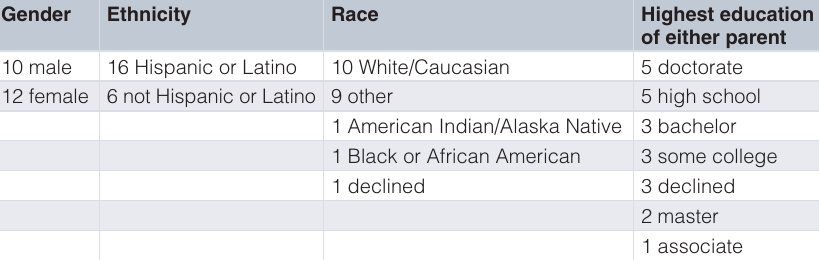
Table 1. Demographic characteristics of